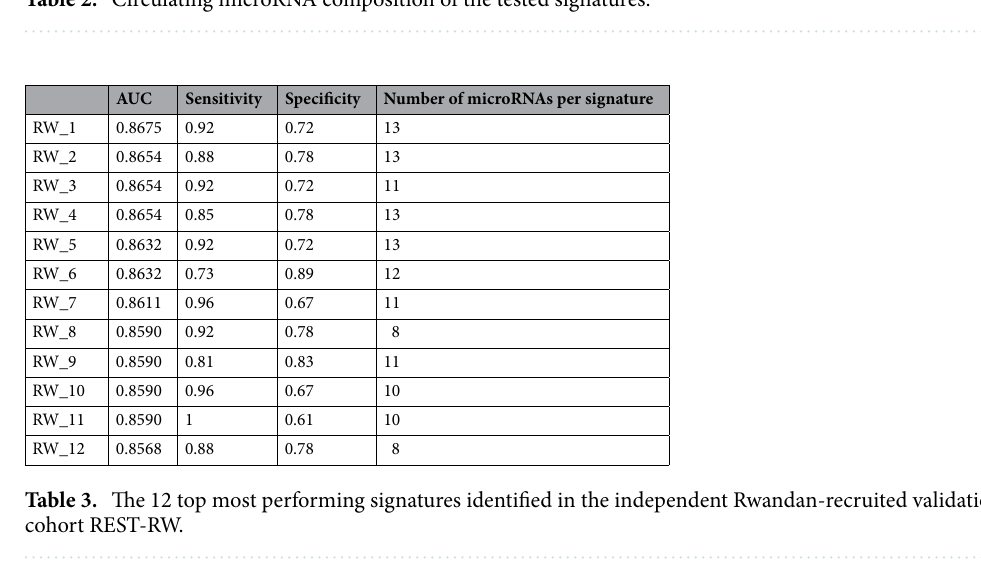
Table 2. Circulating microRNA composition of the tested signatures.